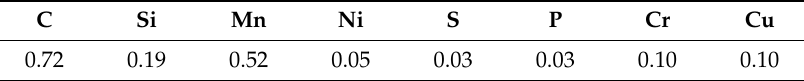
Table 1. Nominal chemical composition of high carbon steel (mass fraction,